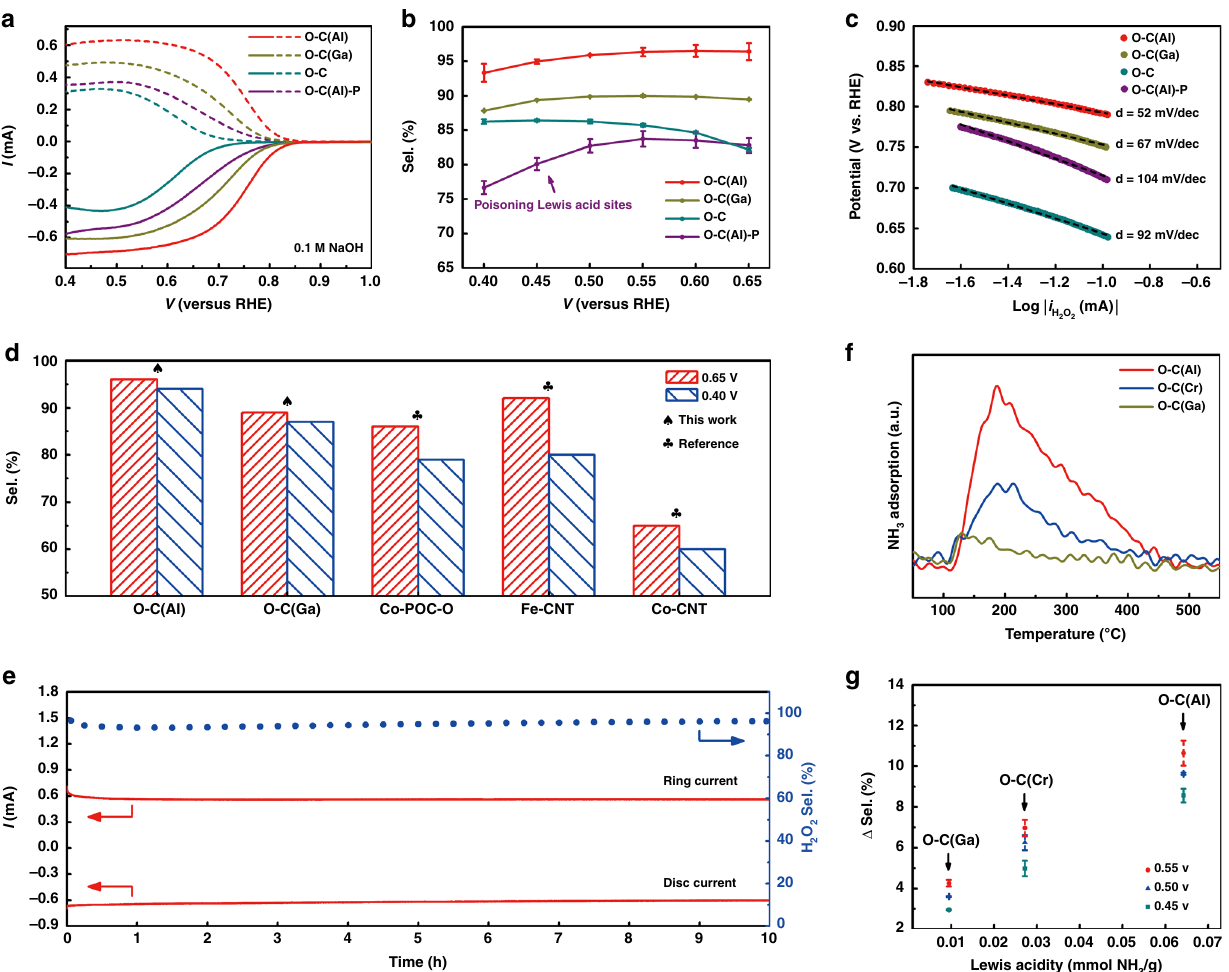
Fig. 3 Electrocatalytic performance of O – C(M) and O – C towards 2-electron ORR in 0.1 M NaOH. a Illustration showing the process of O 2 reduction to H 2 O 2 over O – C(M) catalysts. Linear sweep voltammetry (LSV) curves of O – C(Al), O – C(Ga), O – C, and O – C(Al) – P (solid lines) together with the corresponding H 2 O 2 currents on the ring electrode (dashed lines) recorded at 1600 rpm. b Calculated H 2 O 2 selectivity during the potential sweep. c Tafel slopes of O – C(Al), O – C(Ga), O – C, and O – C(Al) – P in 0.1 M NaOH solution. d The H 2 O 2 selectivity of O – C(M) and reference catalysts at low overpotential (0.65 V) and high overpotential (0.4 V). e Stability measurement of O – C(Al) at a fi xed disk potential of ~0.47 V. f NH 3 -TPD pro fi les of O – C(Al), O – C(Cr), and O – C(Ga). g The correlation between the increased selectivity (compared with O – C catalyst) and Lewis acidity of O – C(M) catalysts at various